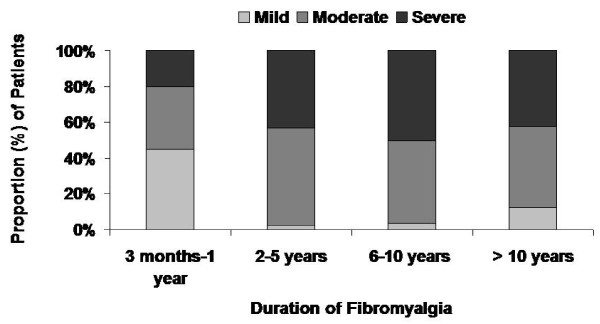
Relationship between duration of fibromyalgia and patient self-reported fibromyalgia severity. The percentages reflect the proportion of patients with the indicated duration of fibromyalgia who were at each self-reported severity level (e.g. of patients with fibromyalgia < 1 year, 45% reported mild disease). Chi-square = 27.22, df = 6; p = 0.0001.